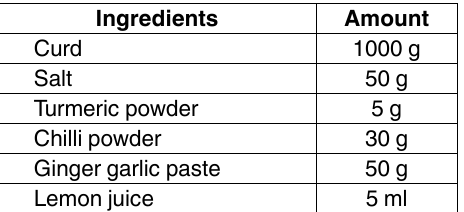
Table 1. Formulation of tandoori marinade for 1 Kg of